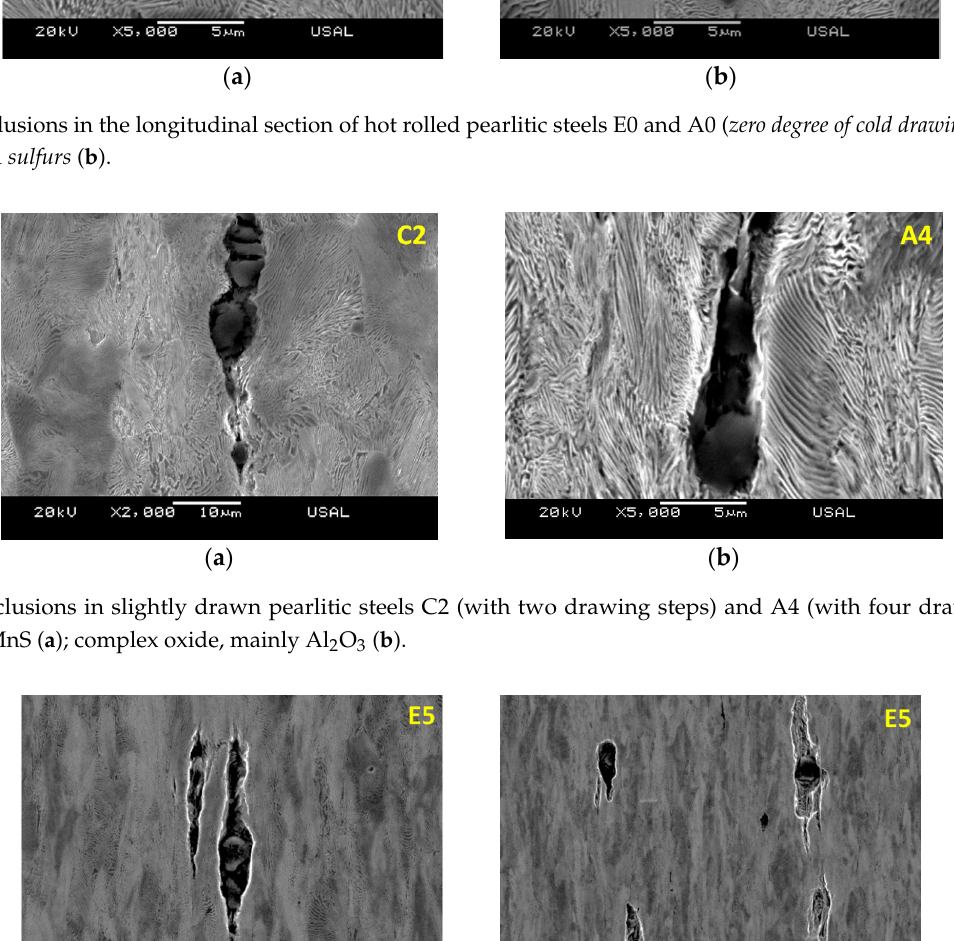
Figure 9. Inclusions in slightly drawn pearlitic steels C2 (with two drawing steps) and A4 (with four drawing steps). Principally MnS ( a ); complex oxide, mainly Al 2 O 3 ( b ).